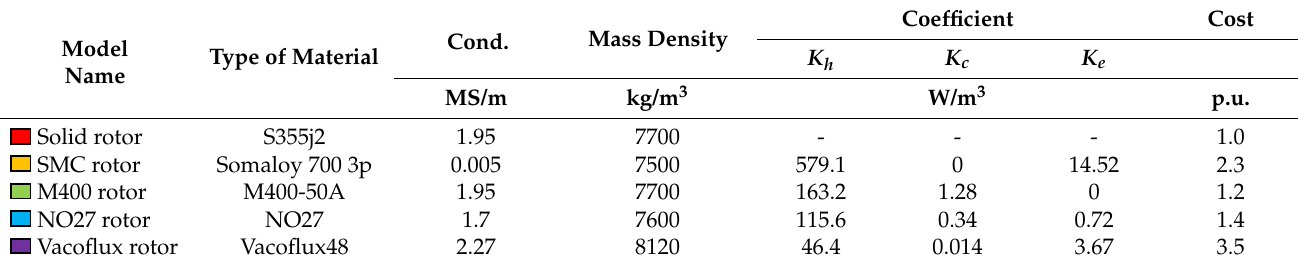
Table 2. Basic properties of the analyzed materials in the rotor yoke.